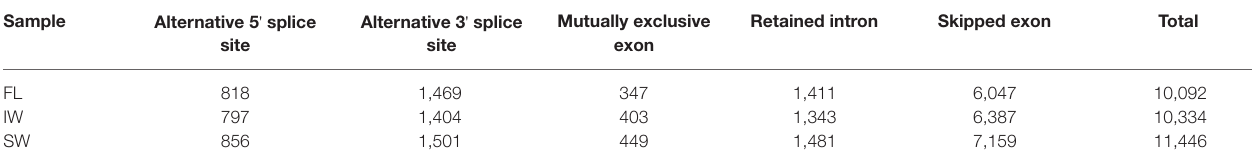
TABLE 2 | Statistics of alternative splicing events at fresh leaves (FL), indoor-withered leaves (IW), and solar-withered leaves (SW).